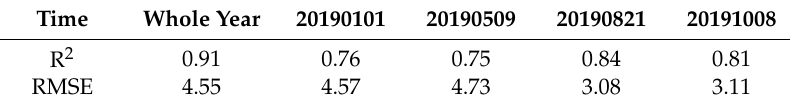
Table 2. R 2 and RMSE between remote sensing mapping results and station measurements.